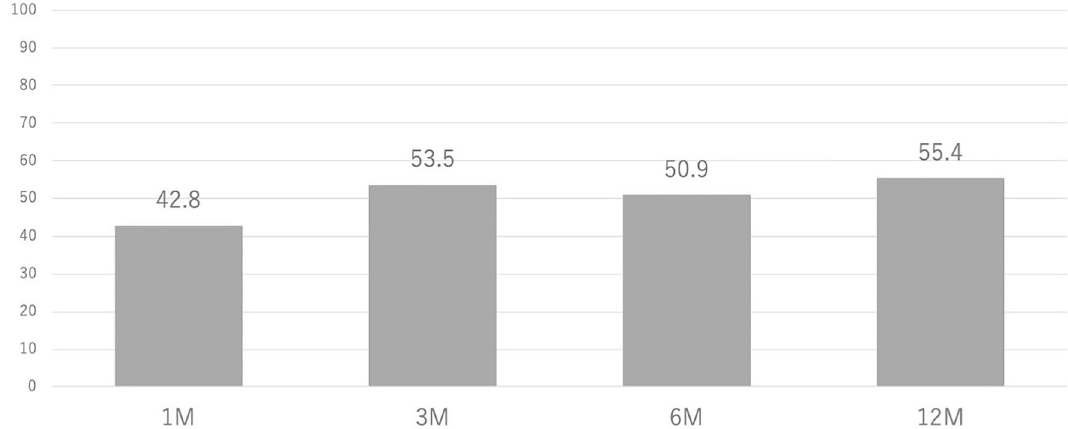
Figure 4. Responder rate in OMETACT–OARSI criteria in the patient followed up at each time point.